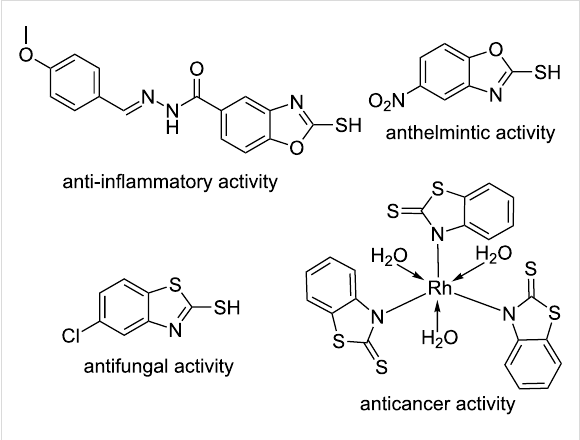
Figure 1: Representative examples of biologically active 2-mercapto- benzoxazoles and 2-mercaptobenzothiazoles.